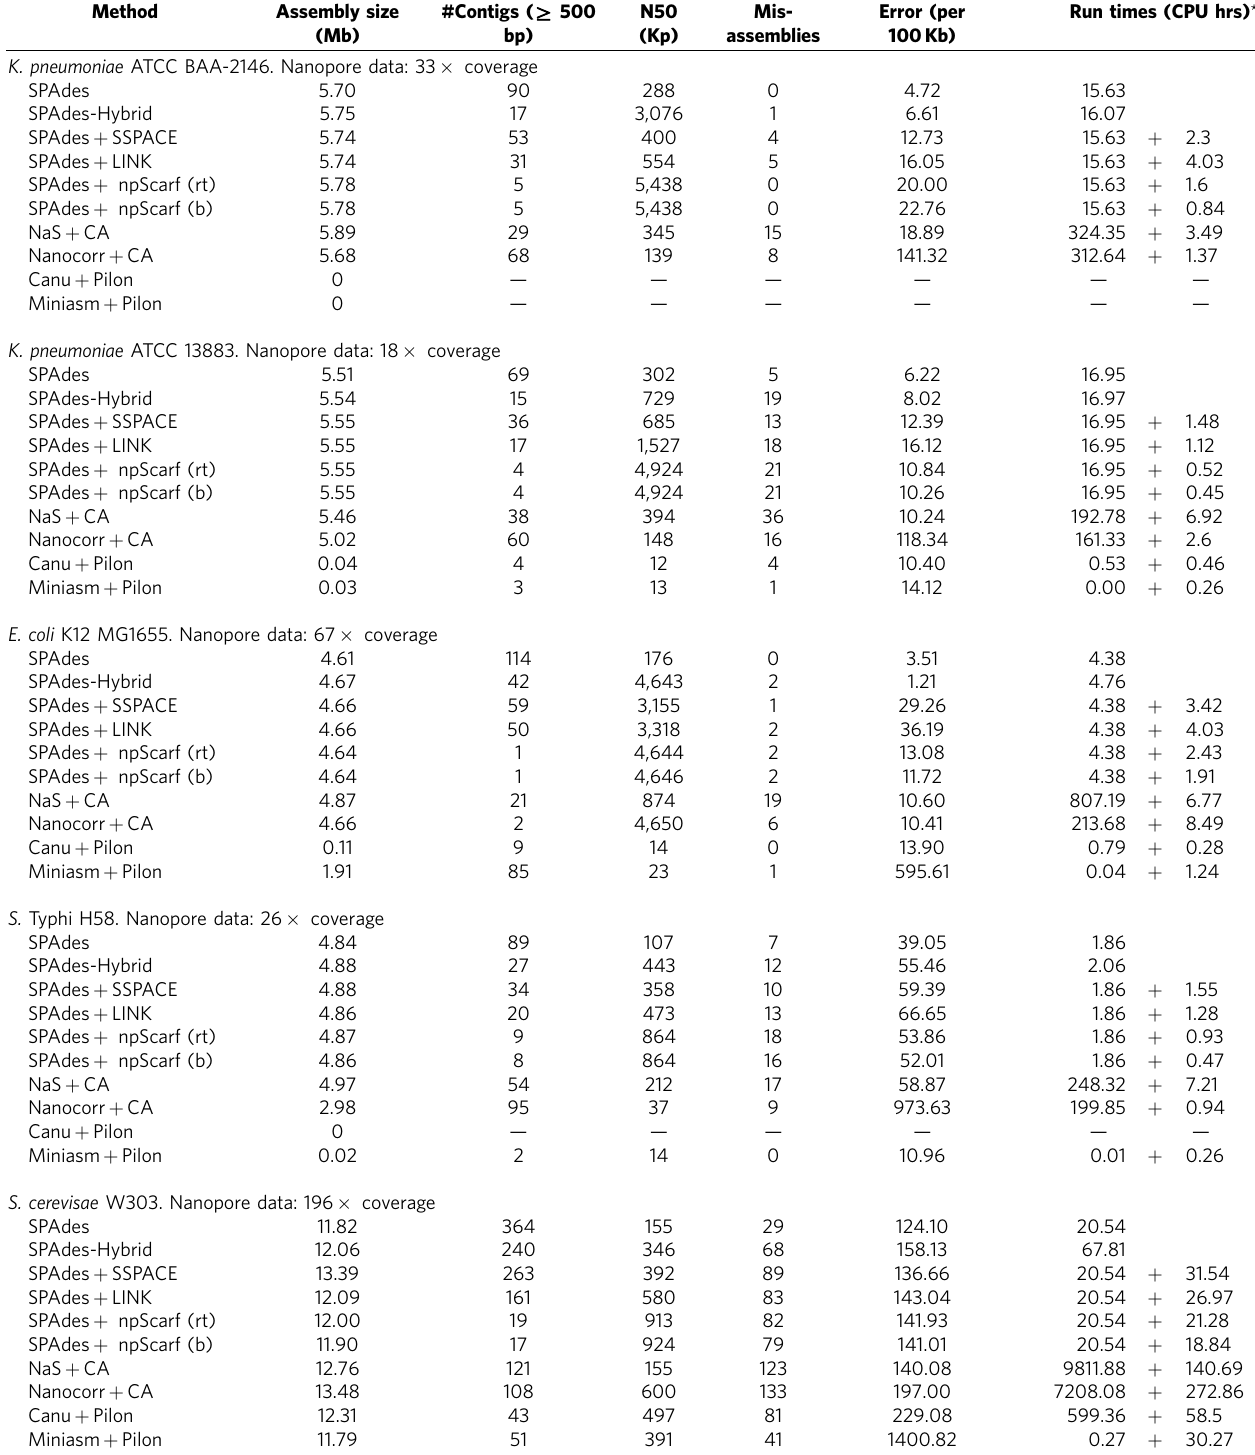
Table 3 | Comparison of assemblies produced by npScarf and the comparative methods.